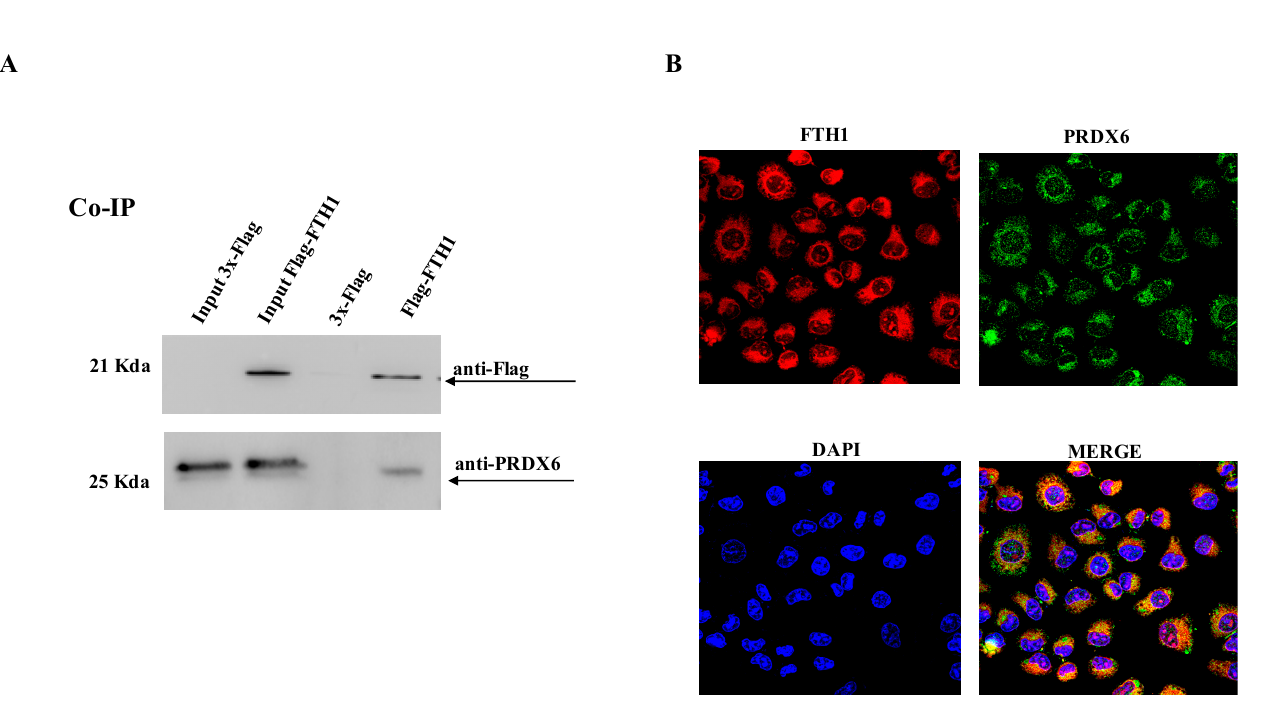
Table 1. FTH1 (left) and PRDX6 (right) most relevant, quartile 1, interacting residues. FTH1